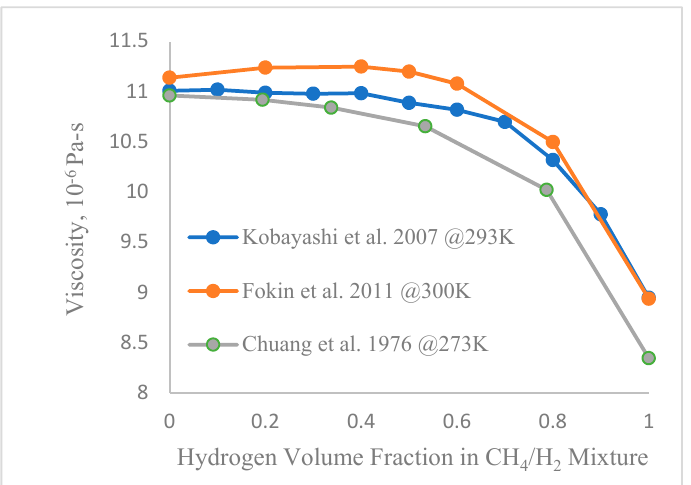
Figure 2. Viscosity variation as a function of hydrogen concentration in hydrogen-methane mixture ( Data from references [11–13]).